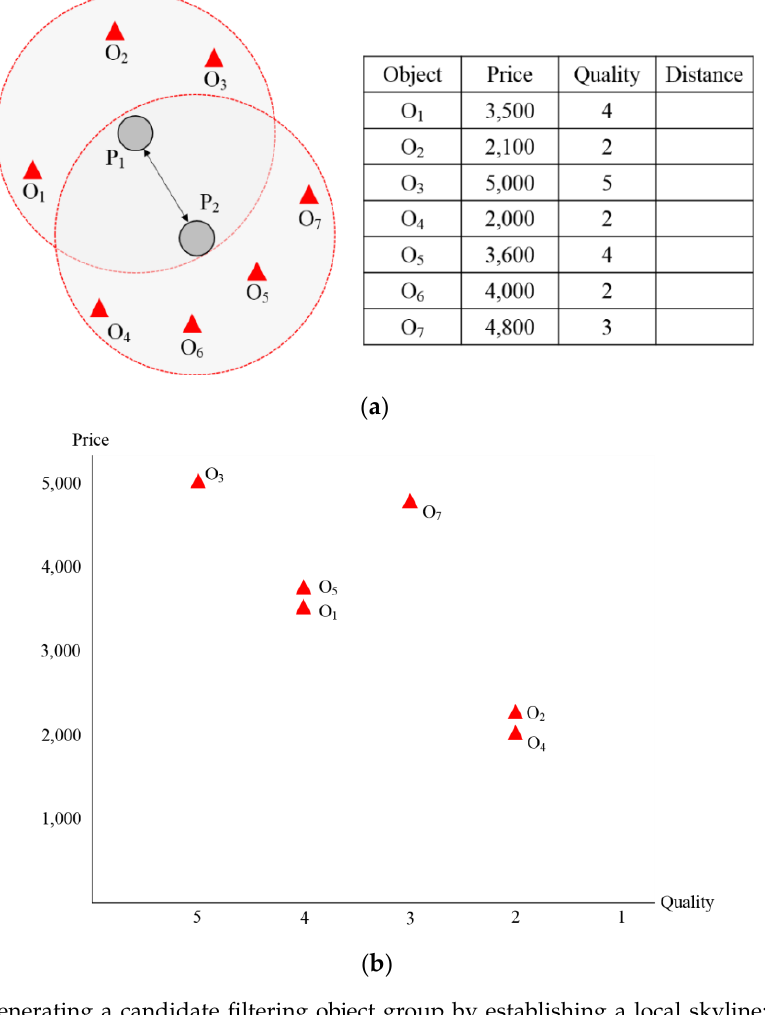
Figure 5. Generating a candidate filtering object group by establishing a local skyline: ( a ) object information stored in 𝑃 1 ; ( b ) local skyline. information stored in P 1 ; ( b ) local